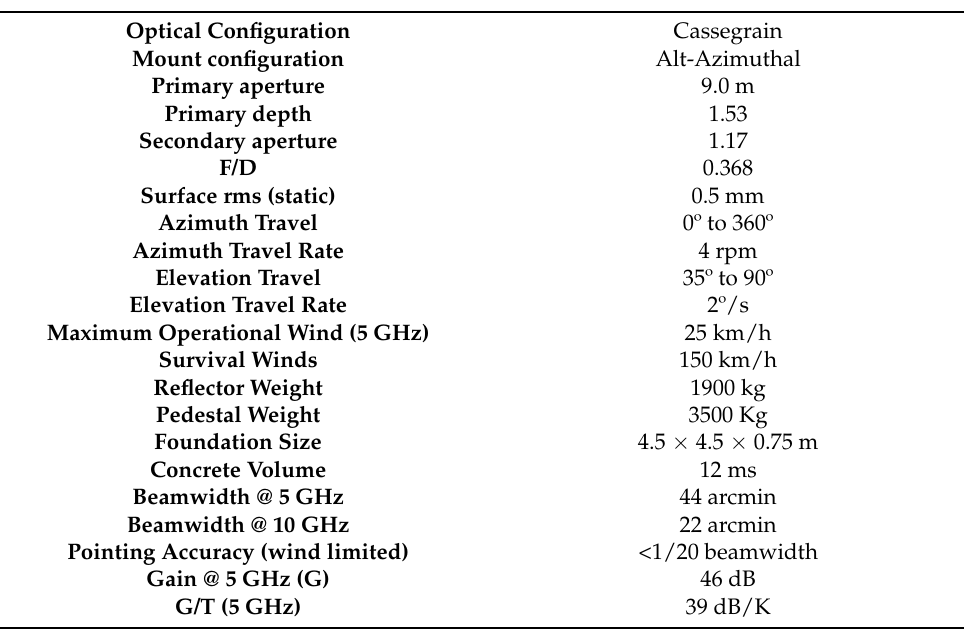
Figure 2. ATLAS Antenna. Table 2. Antenna